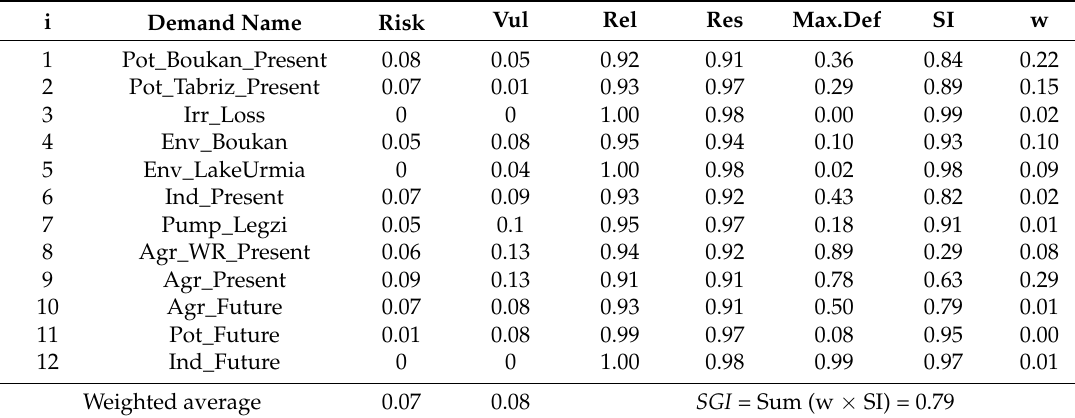
Table 8. ZRB water supply system performance based on the Reliability, Resilience, and Vulnerability (RRV) indices and the ensuing Sustainability Indexes (SIs) (Equation (6)), for the various water uses and the final total Sustainability Group Index ( SGI ) for the WD recom scenario/RCP45/2030period. The last column lists the normalized weights w i = Dem i / Dem k entering the SGI -Equation